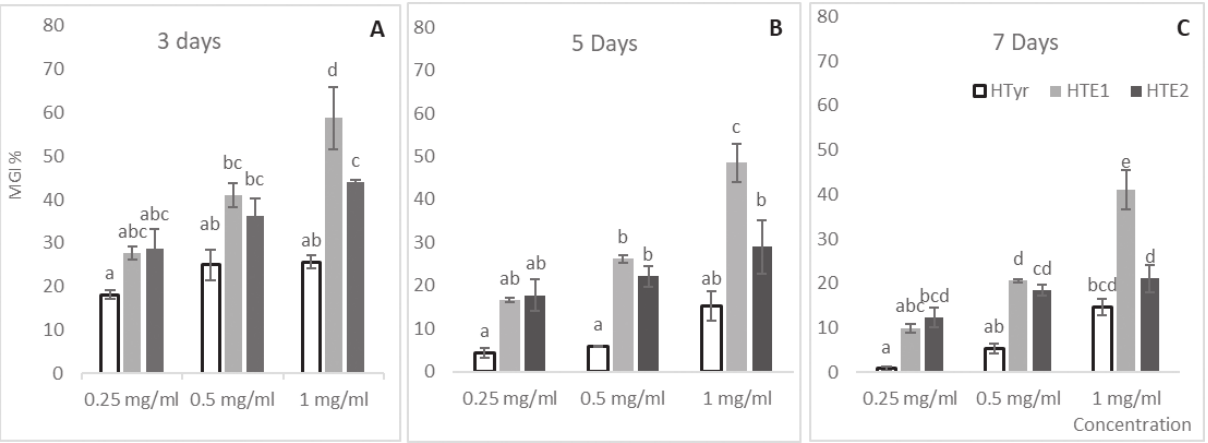
Figure 3. V erticillium dahliae mycelium growth inhibition percent (MGI %) in top agar assays. The data for different concentrations of HTyr, HTE1 and HTE2 are presented for 3 (A), 5 (B) and 7 (C) d of incubation. Bars indicate standard errors of triplicates and different let- ters indicate differences ( P < 0.05), according Tukey’s (HSD) multiple range